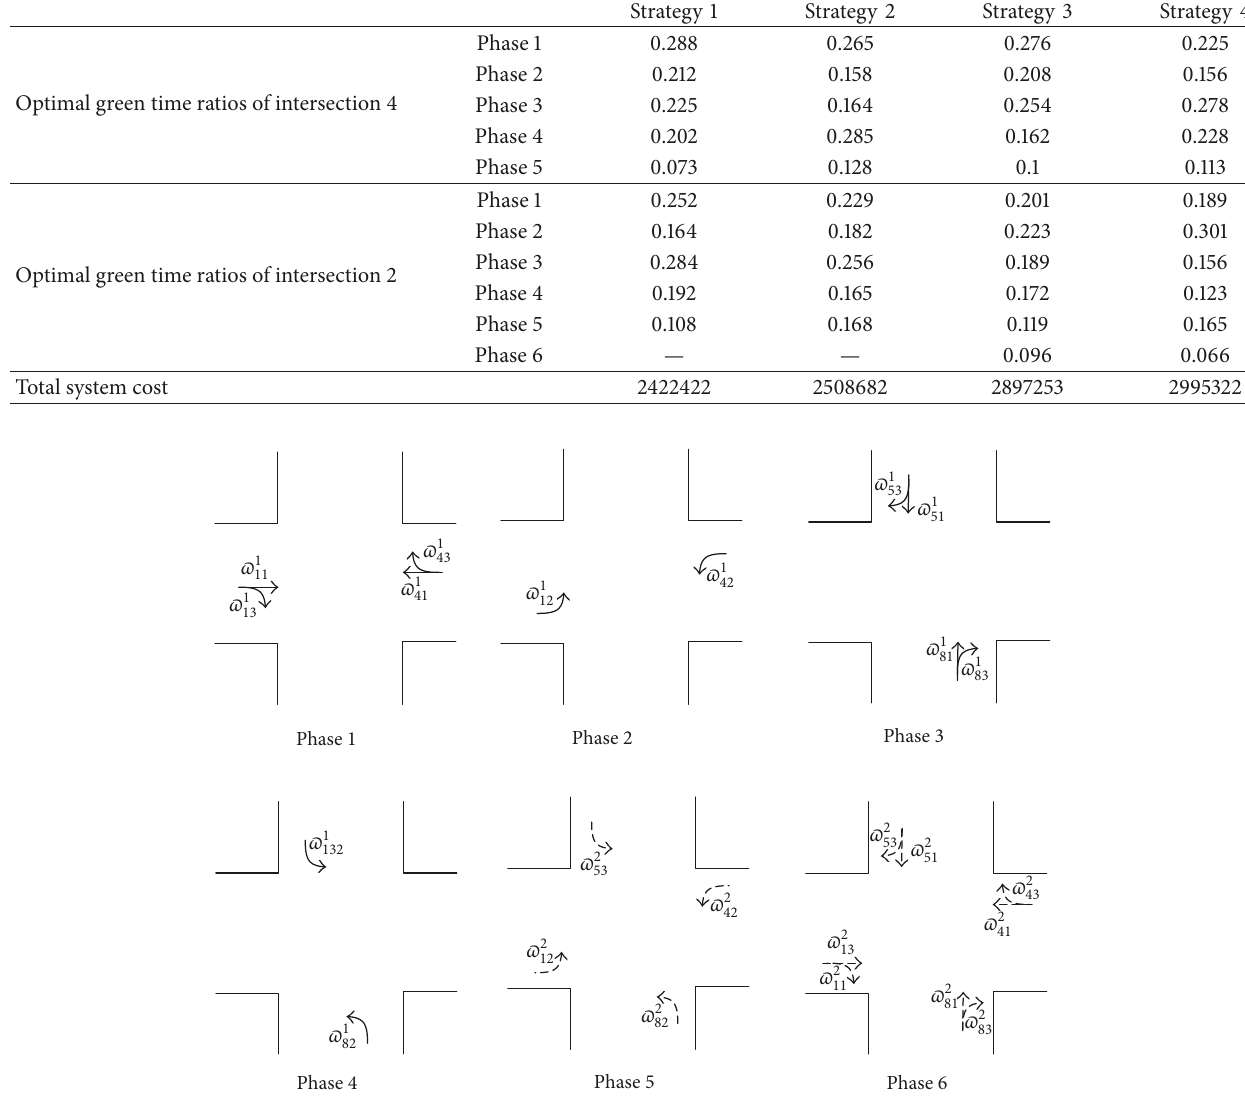
Figure 8: Illustration of control strategy 4 in intersection